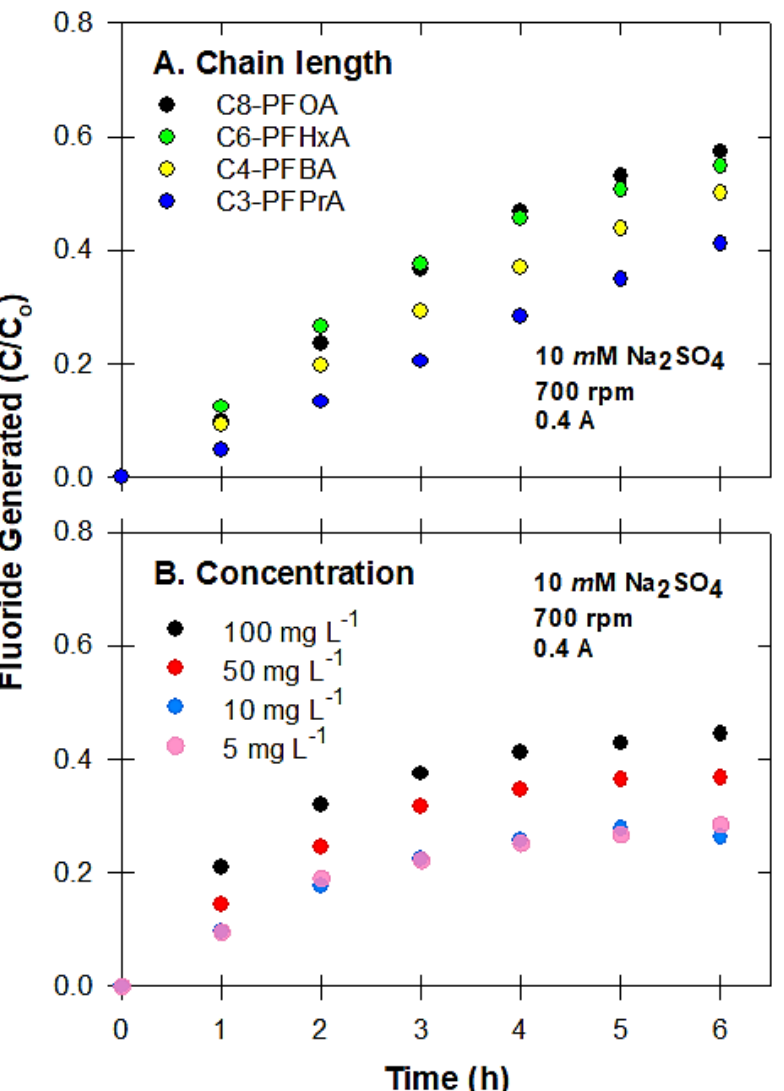
Figure 7. ( A ) Effects of initial concentration on defluorination rates; ( B ) defluorination rates of various carbon chain length perfluorinated carbonates.